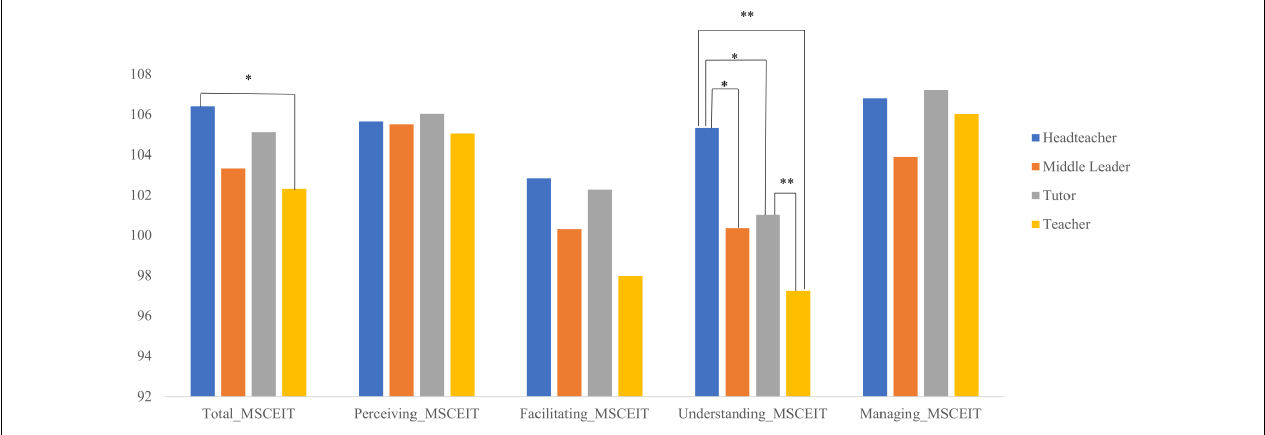
FIGURE 2 | Differences in emotional intelligence according to work position. ∗ p < 0.05; ∗∗ p <